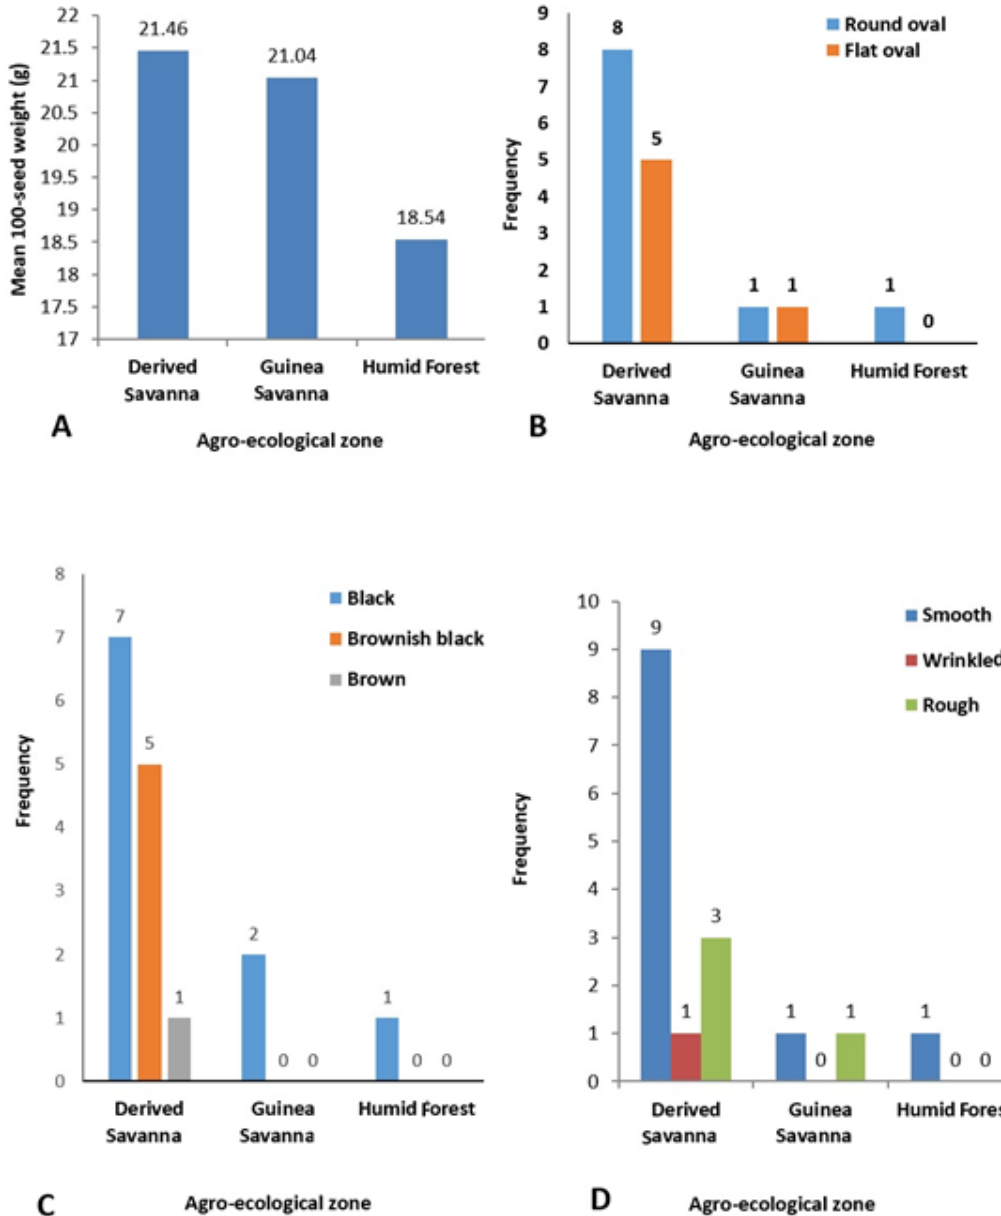
Figure 2. Distribution frequencies of seed characteristics of Parkia biglobosa across agro-ecological zones. A) 100-seed weight (g); B) Seed shape; C) Seedcolour; D) Seed coat